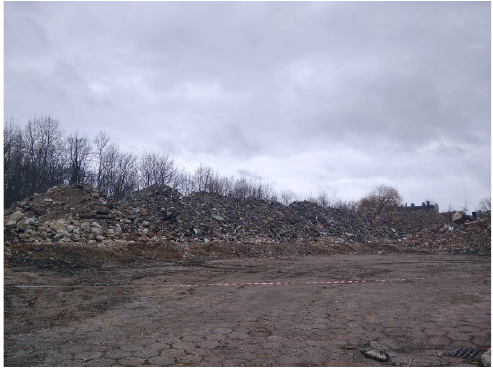
Figure 16. Example of construction waste landfill.